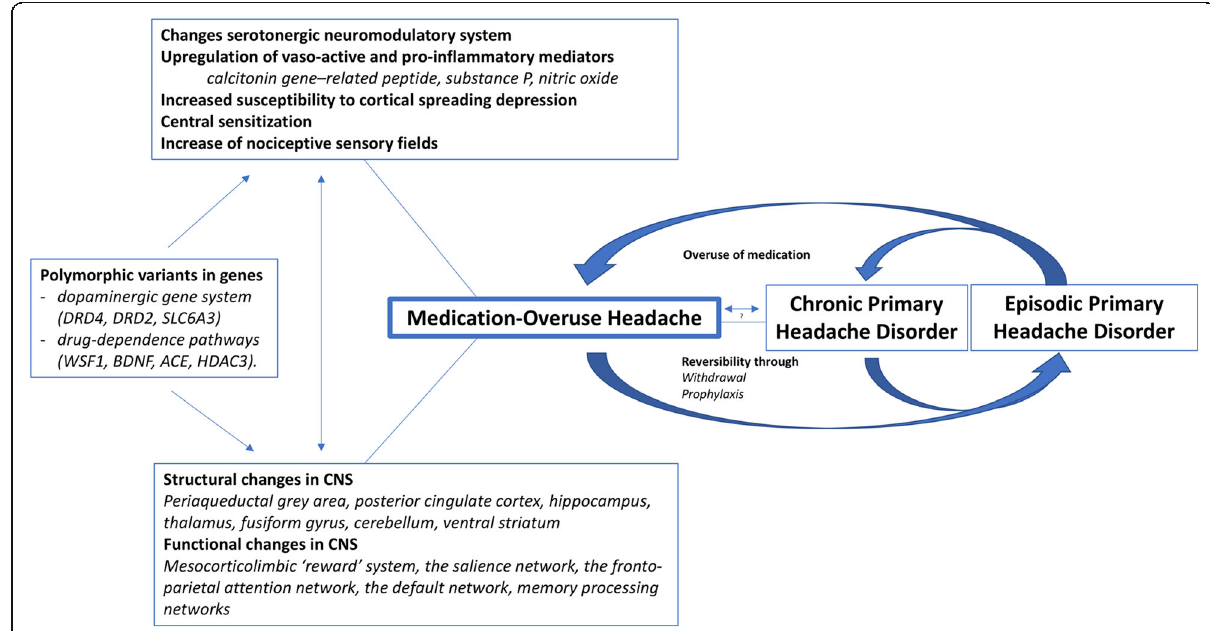
Fig. 1 Current understanding of the pathophysiology of medication-overuse headache (MOH). The knowledge on the pathophysiology of MOH involves conversion from and reversion to primary headache disorders, showing changes in physiological processes, functional connectivity and structural changes of the central nervous system, in patients with underlying genetic susceptibility. Abbreviations: MOH: medication-overuse headache; CNS: central nervous